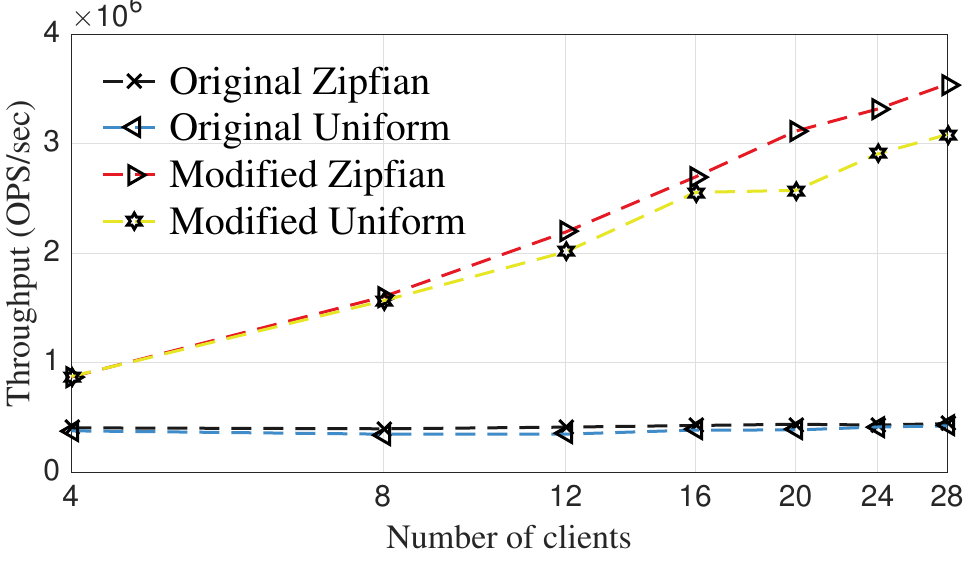
Figure 16. HydraDB Put transaction